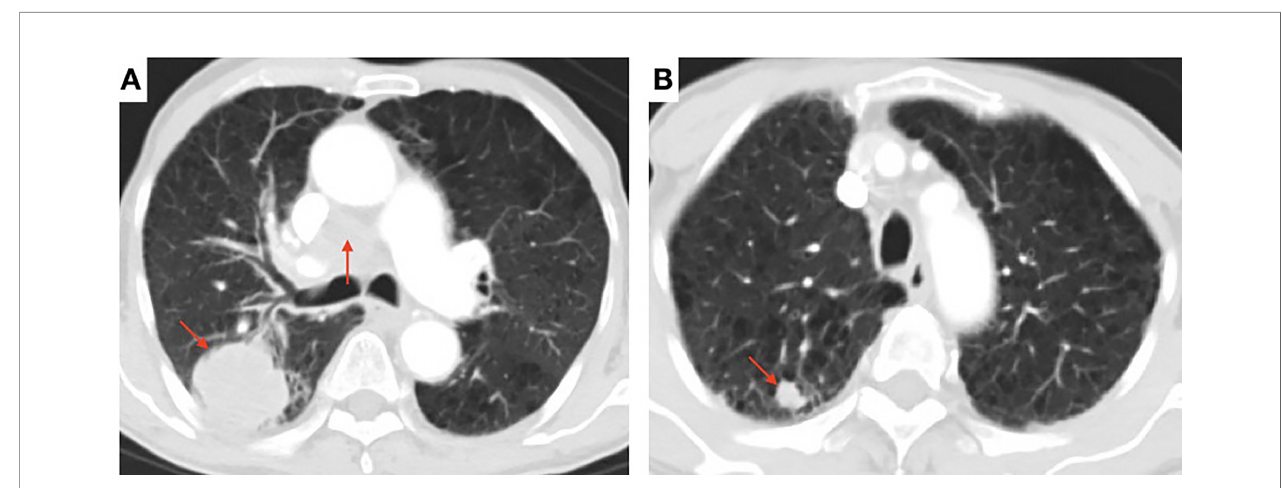
FIGURE 1 | Contrast-enhanced chest computed tomography (CT) scan showing (A) a soft mass (45 × 43 mm) in the posterior segment of the right upper lobe and the enlarged right hilar and mediastinal lymph nodes (arrow) and (B) multiple pulmonary nodules with a maximum diameter of 20 × 14 mm